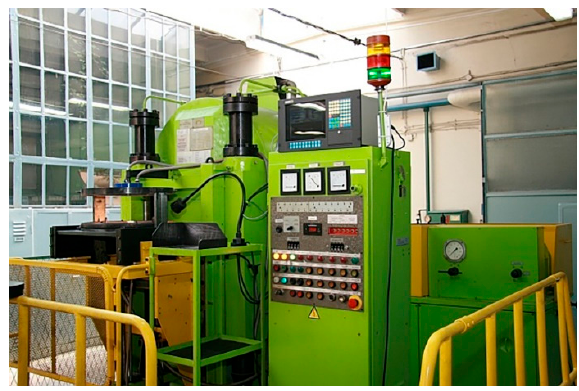
Figure 5. Device for high pressure spark plasma sintering [133].